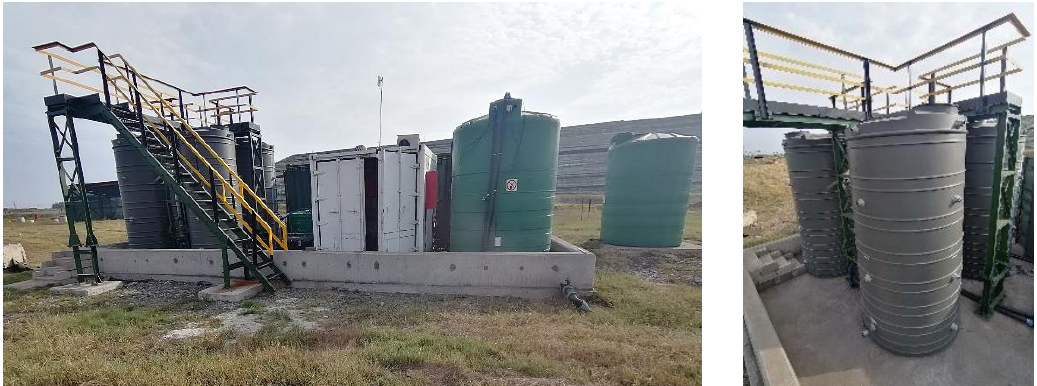
Figure 2. Semi-active pump and treatment plant implemented at site B, located in the North West province of South Africa